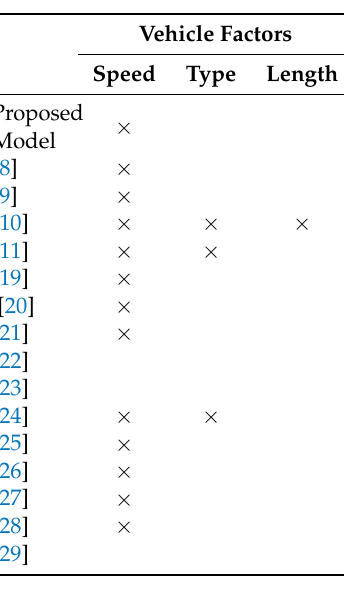
Table 16. Vehicle and driver factors